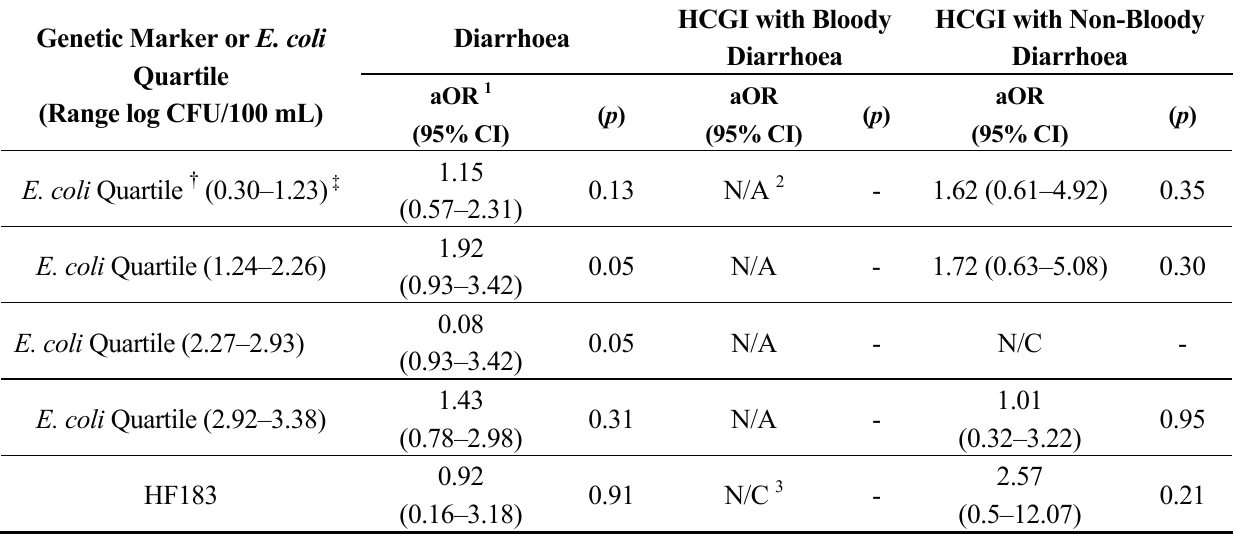
Table 6. Adjusted odds ratios for diarrhoea, HCGI-BD & HCGI-NBD associated with various exposures levels to E. coli , HF183, or tet